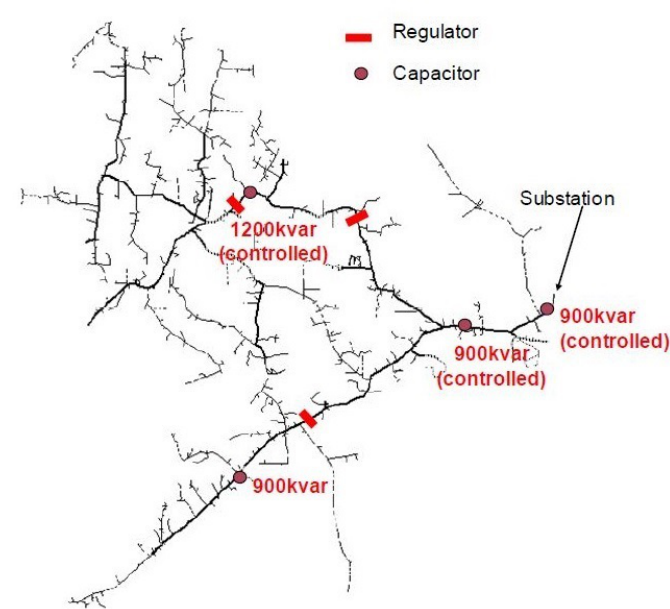
Figure 1. One line diagram of the IEEE-8500 Node Test Feeder